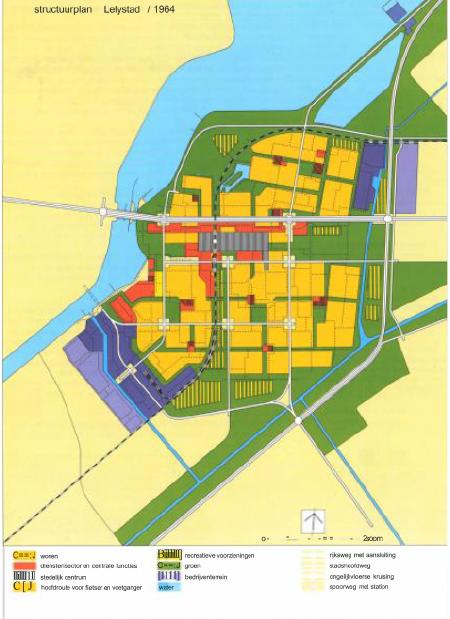
Figure 5. Structure plan 1964 (see also Figure 4).